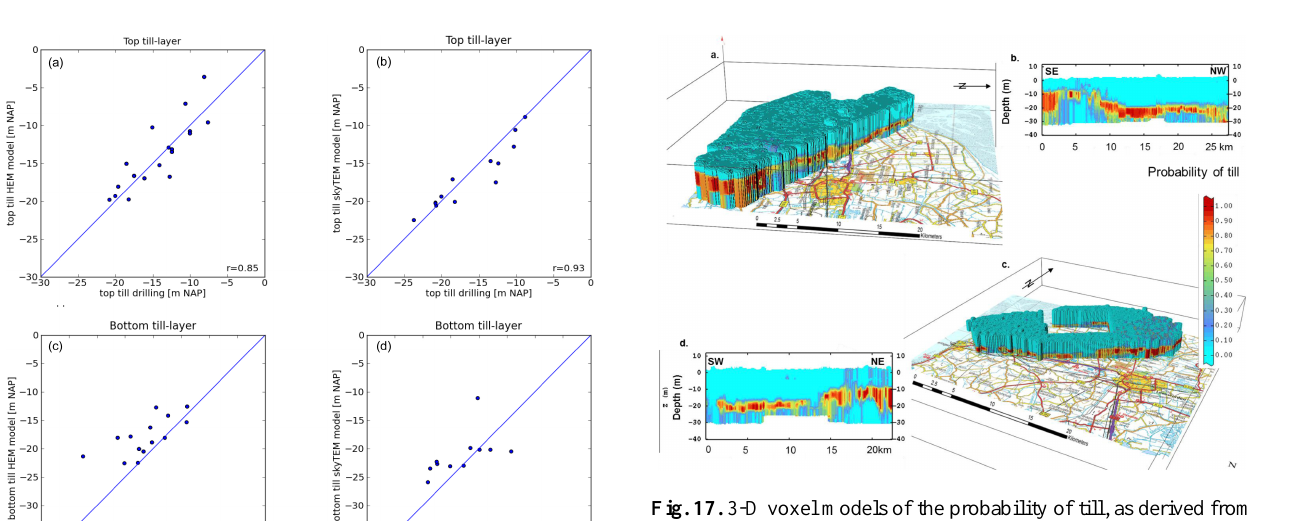
Fig. 17. 3-D voxel models of the probability of till, as derived from ANN of HEM and SkyTEM models. (a) and (b) are derived from SkyTEM models, (c) and (d) from HEM models. Cross section (b) is A-A’ in Fig. 1; cross section (d) is B-B’ in Fig.